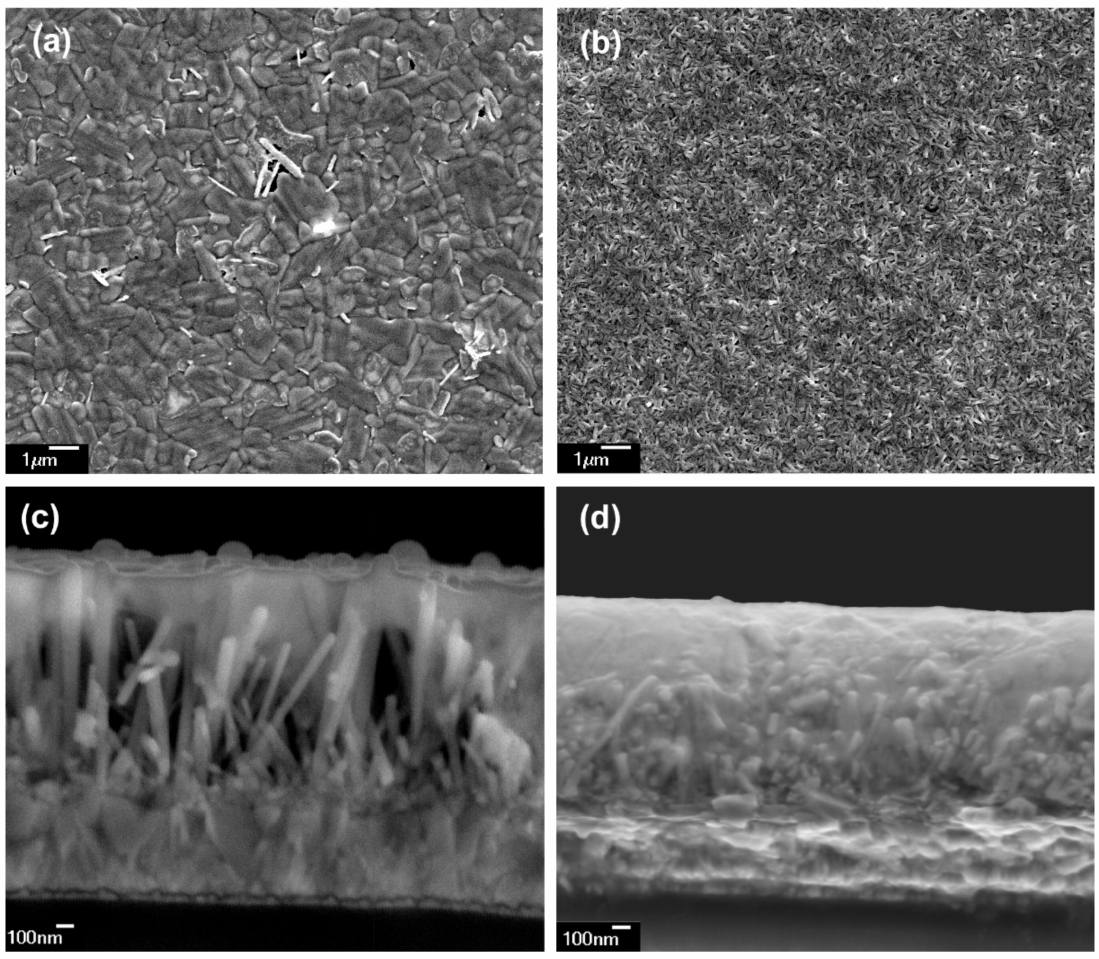
Figure 4. SEM micrographs: ( a ) top view of FAPI perovskite on ZNR, ( b ) top view of FAPI perovskite with PVP on ZNR, ( c ) cross-sections of FAPI perovskite on ZNR, and ( d ) cross-sections of FAPI perovskite with PVP on